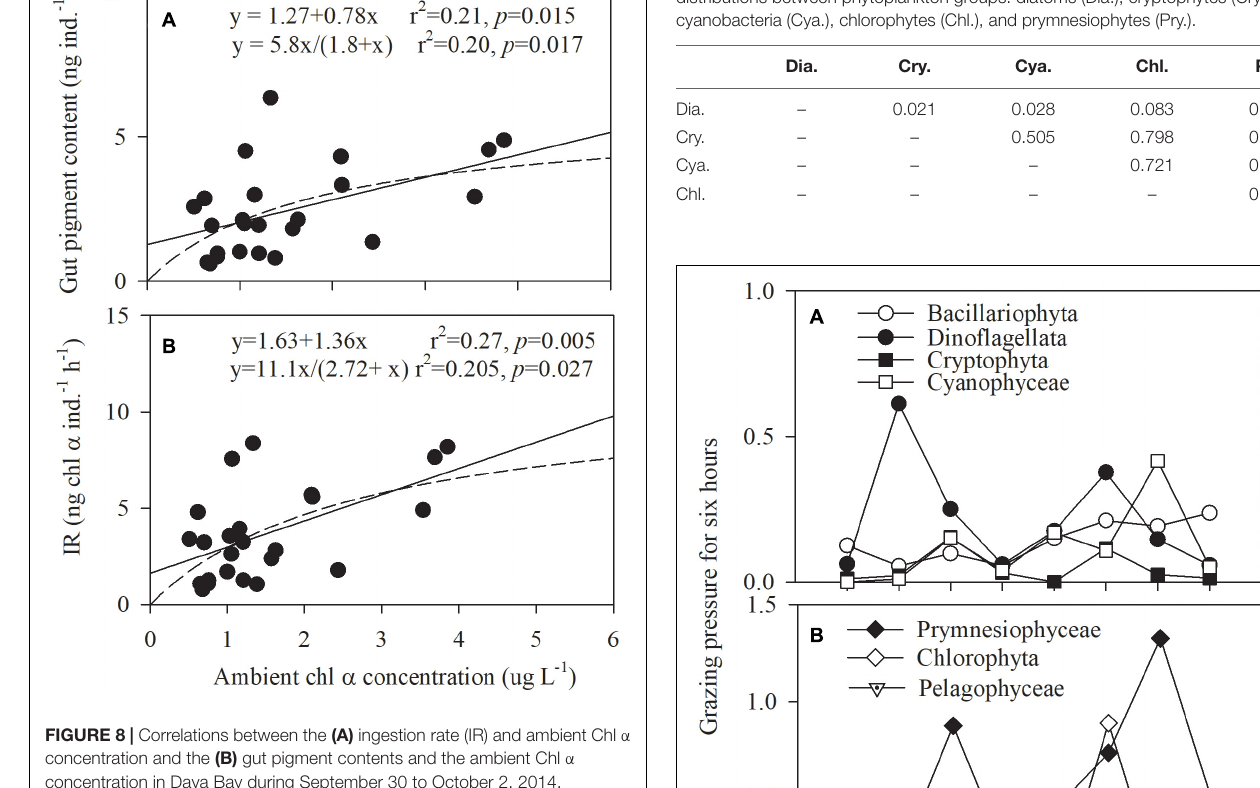
TABLE 4 | P- values from Mann-Whitney tests for differences in selectivity index distributions between phytoplankton groups: diatoms (Dia.), cryptophytes (Cry.),